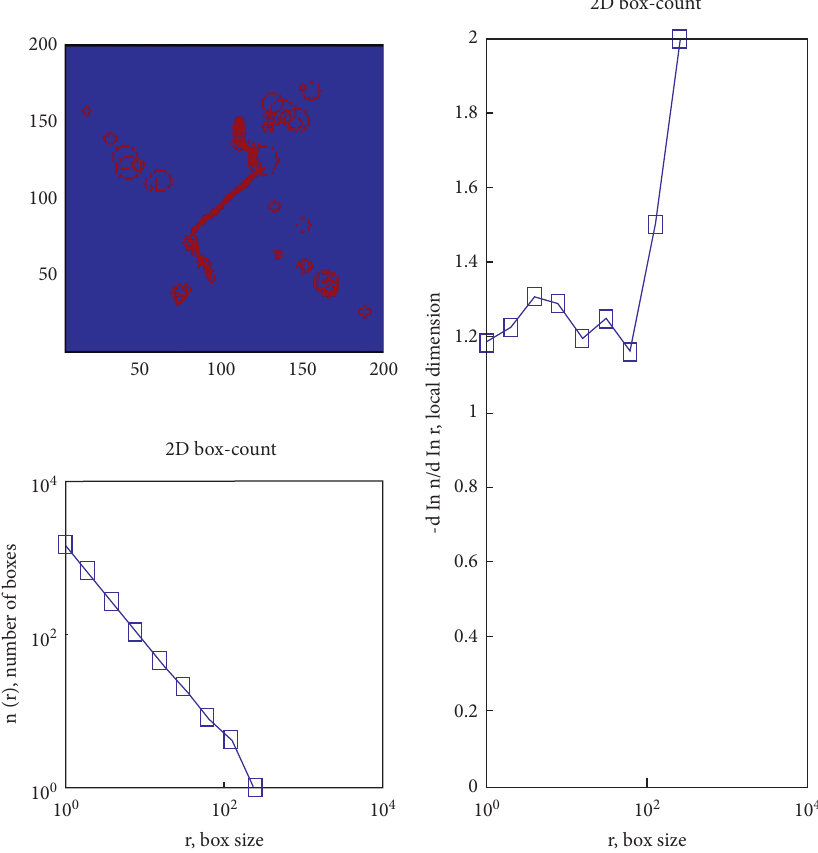
Figure 10: when α � 45 ° , the fractal dimension is calculated (the stress level is 70%